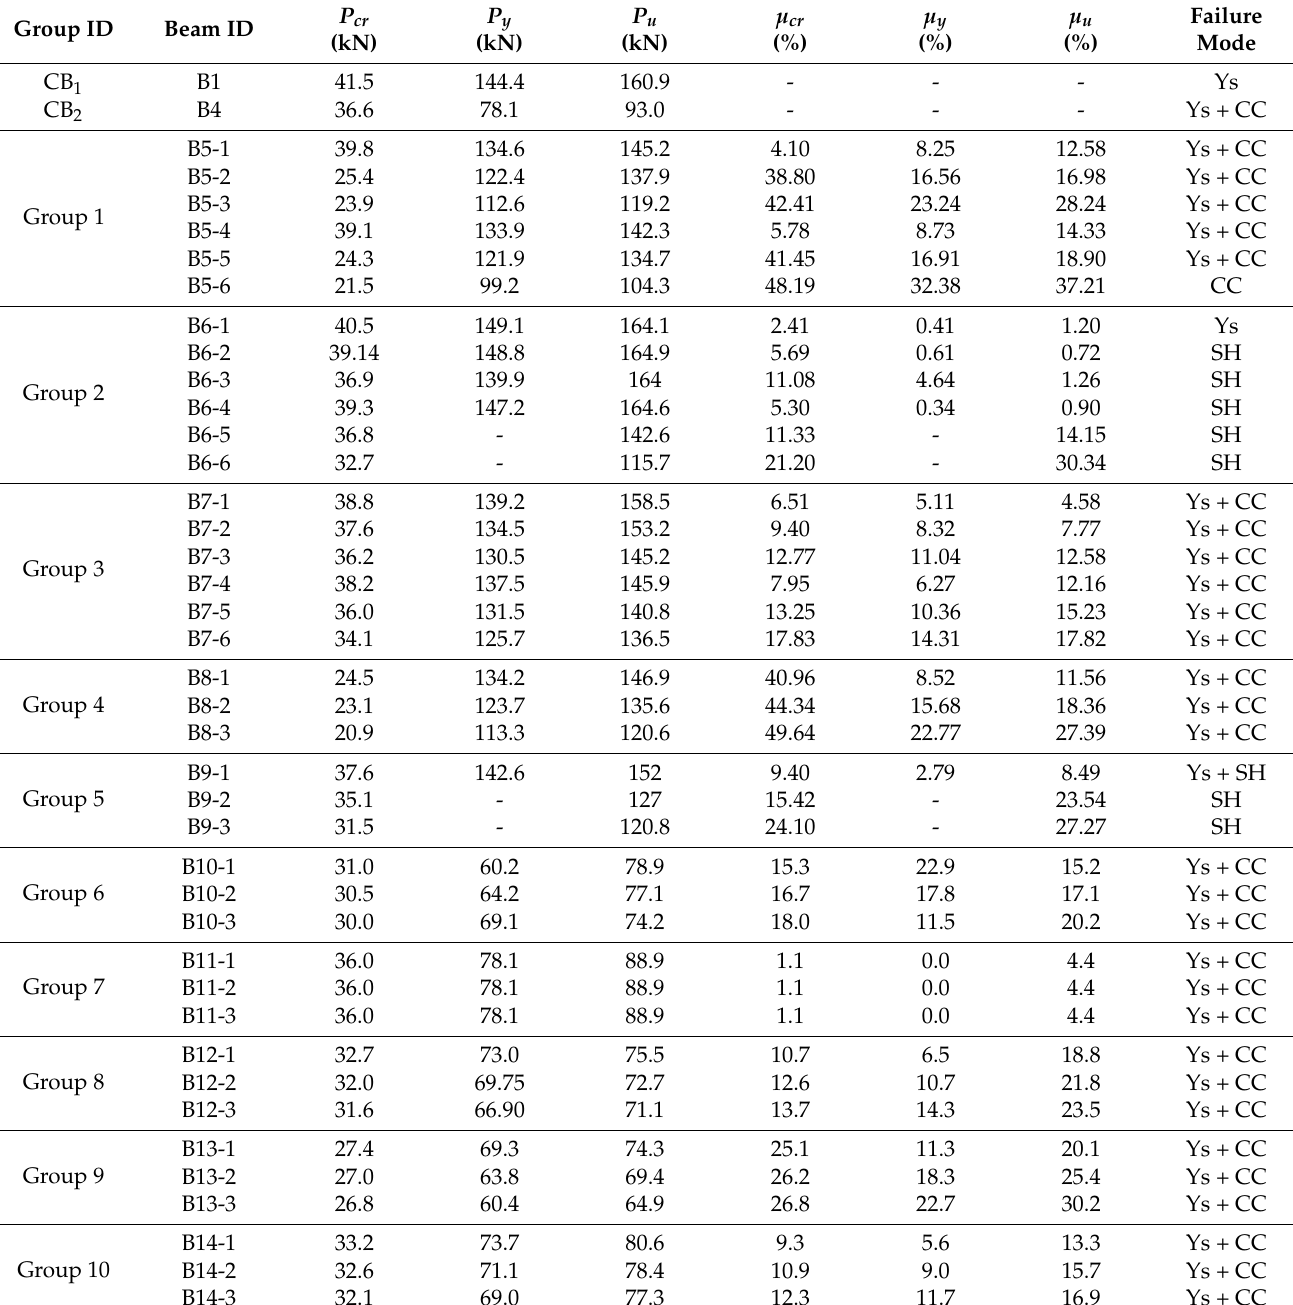
Table 6. The FEA results of the simulated beams with different